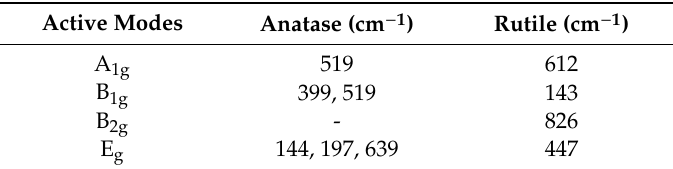
Table 1. Raman active modes for anatase and